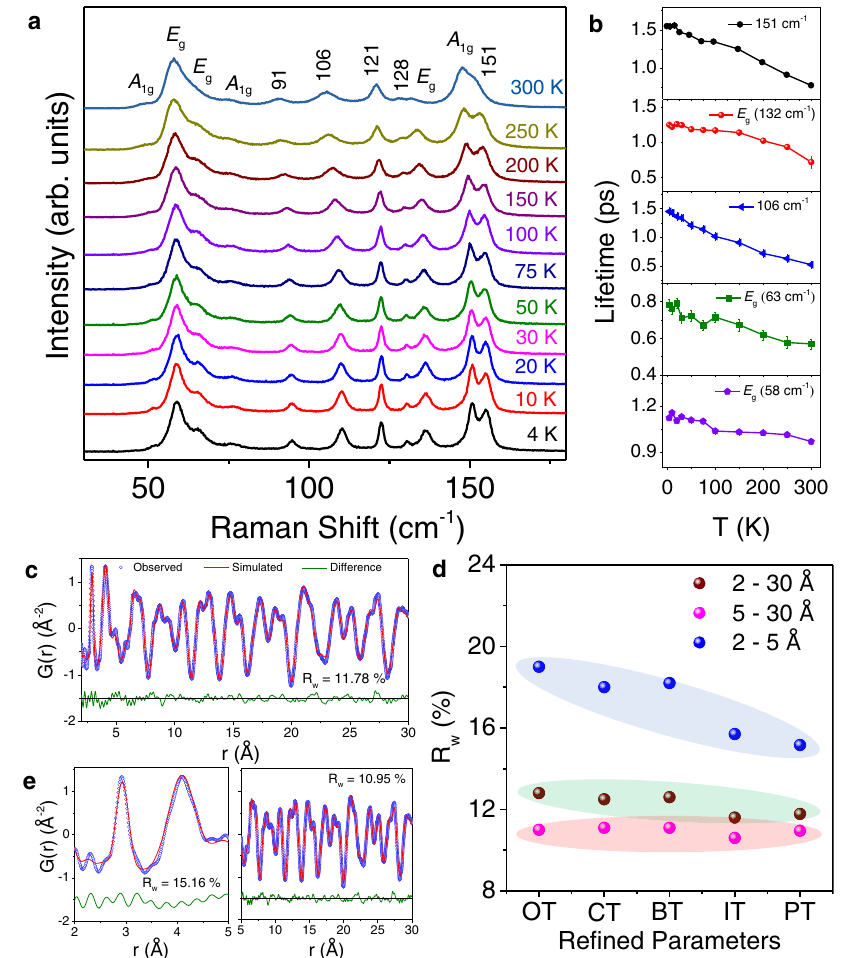
Fig. 4 | Vibrational characteristics and local structure of Cs 3 Bi 2 I 6 Cl 3 . a Temperature-dependent Raman spectra and b temperature variation of phonon lifetime for various modes of Cs 3 Bi 2 I 6 Cl 3 . c Room temperature synchrotron X-ray PDF data fi tted using P − 3 m 1 space group (ambient crystal structure) with all atom positionsandthermalparametersre fi nement. d Goodnessof fi t(R w )vs.re fi nement